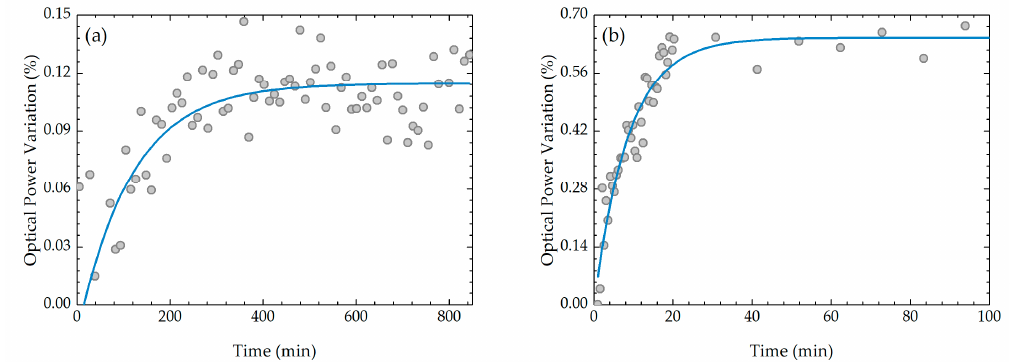
Figure 7. In-situ adsorption kinetics of a layer of graphene oxide onto a ( a ) optical fiber and ( b ) (PEI/GO) 10 /PEI LbL film already adsorbed on the optical fiber.